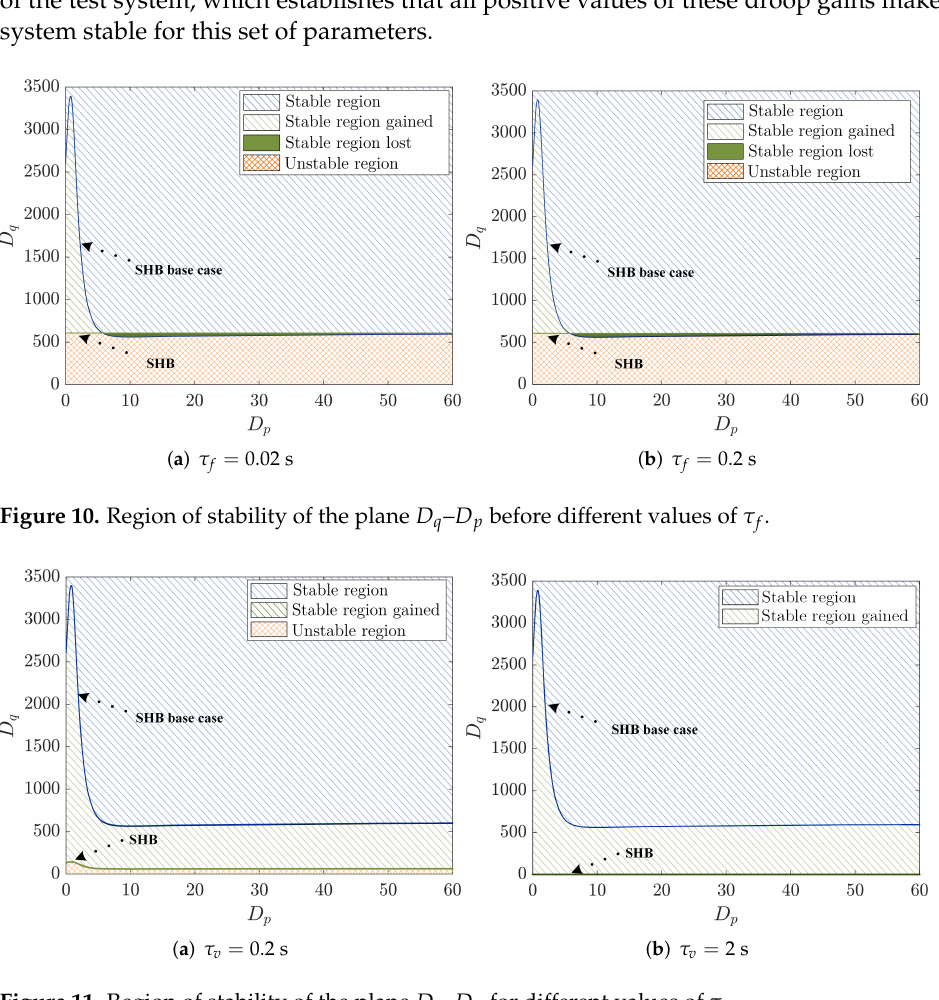
Figure 11. Region of stability of the plane D q – D p for different values of τ v